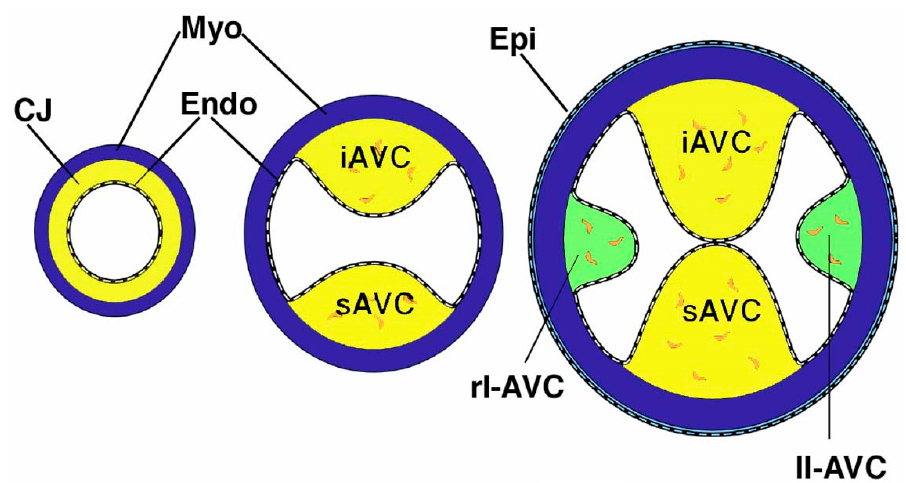
Figure 2. Development of the Atrioventricular Cushions. During formation of the heart tube, extracellular matrix-rich cardiac jelly (yellow) first accumulates between the endocardium and myocardium ( left ). During looping additional accumulation and endoEMT at the dorsal and ventral aspect of the AV canal results in formation of the major AV cushions ( middle ). The lateral cushions (green) form around the time the major cushions are fusing to separate left and right AV canal ( right ). CJ = cardiac jelly, Endo = endocardium, Epi = epicardium, Myo = myocardium, iAVC = inferior AV cushion, sAVC = superior AV cushion, ll-AVC = left lateral AV cushion, rl-AVC = right lateral AV cushion.